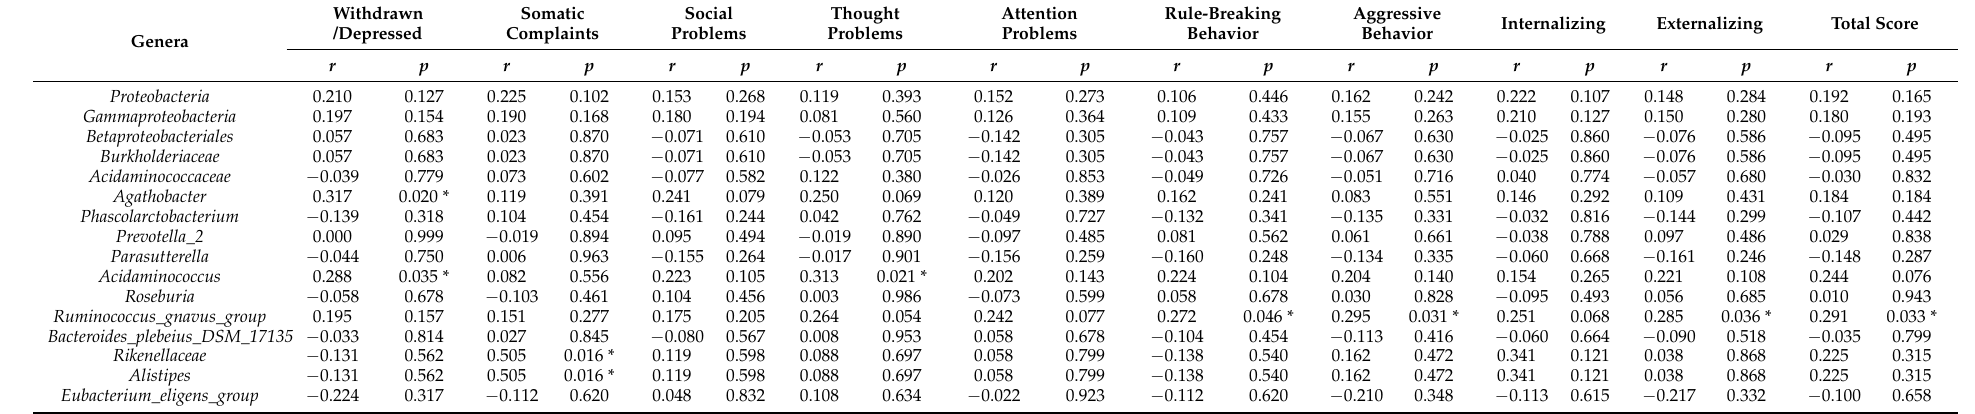
Table 3. The correlation between relative abundance of microbiota and comorbid emotional-behavioral symptoms of attention-deficit/hyperactivity disorder (ADHD) according to Child Behavior Checklist